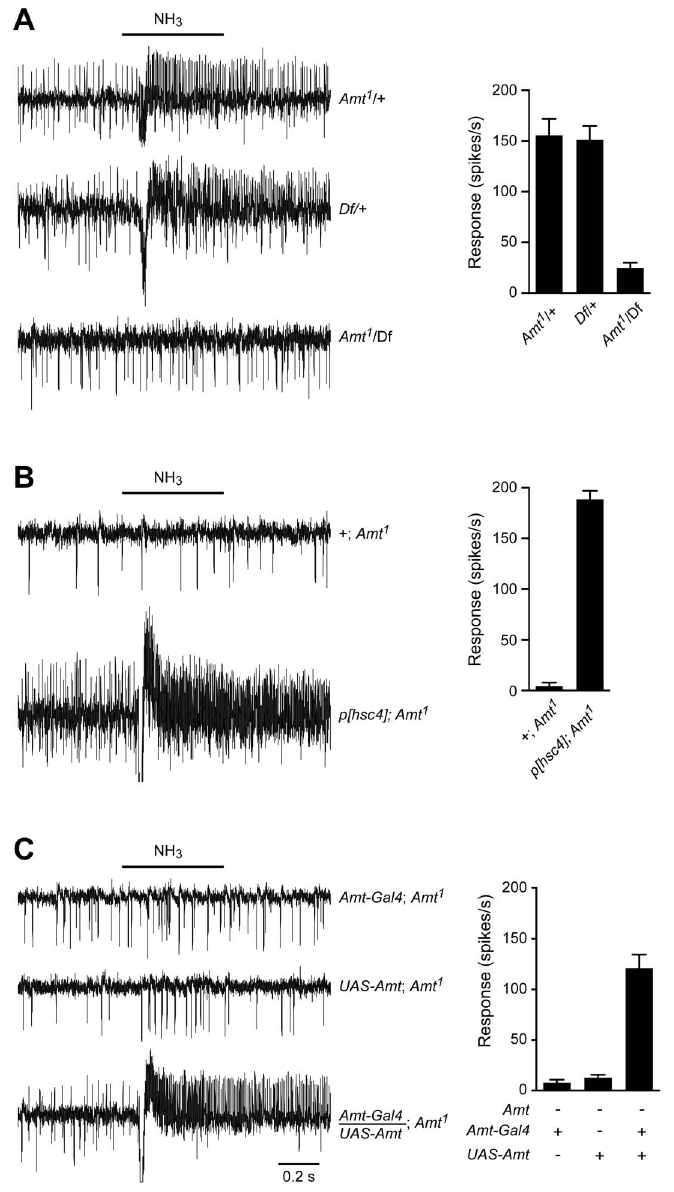
Figure 6. The loss of ammonia response localizes to the Amt gene. (A) Traces on the left show that the responses to a 500 ms pulse of 0.1% ammonia are similar in flies heterozygous for the Amt 1 transposon and the Df(3R)BSC471 deficiency that removes , 30 kb including Amt and nine other genes. In contrast, Amt 1 / Df(3R)BSC471 flies have greatly reduced responses to ammonia (n=9 each, p , 0.0001). Averaged data are shown in the graph on the right. (B) The lack of response to 0.1% ammonia in ac1 sensilla from Amt 1 flies is rescued by the addition of a genomic fragment containing Amt and the neighboring gene Hsc70-4 (n=8 each, p , 0.0001). (C) The response to ammonia in Amt 1 mutant flies is also rescued by transgenic expression of UAS-Amt under the control of an Amt-Gal4 promoter (n=9 each, p ,